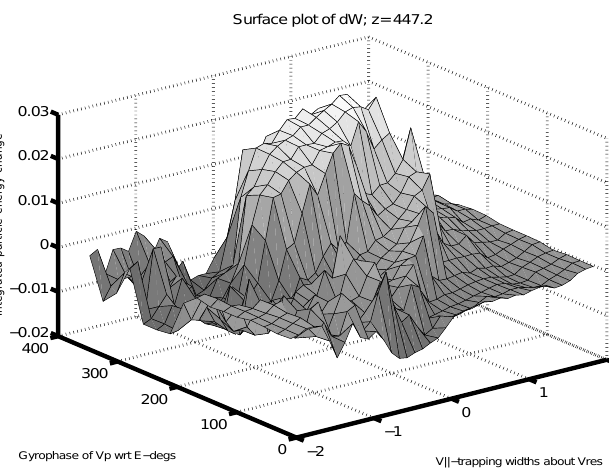
Surface plot of dW; z= 447.2